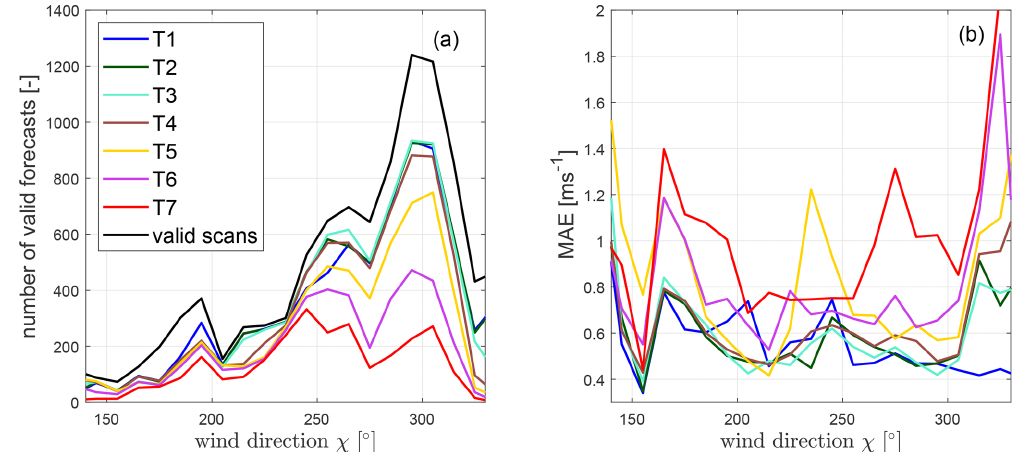
Figure 9. Number of valid forecasts (a) and mean absolute error (MAE; see Sect. 4.3.1), (b) for turbines T1–T7 as a function of wind direction χ sector of 10 ◦ width. The black line in (a) depicts the maximal number of possible forecasts, i.e. the number of valid scans, available for each wind